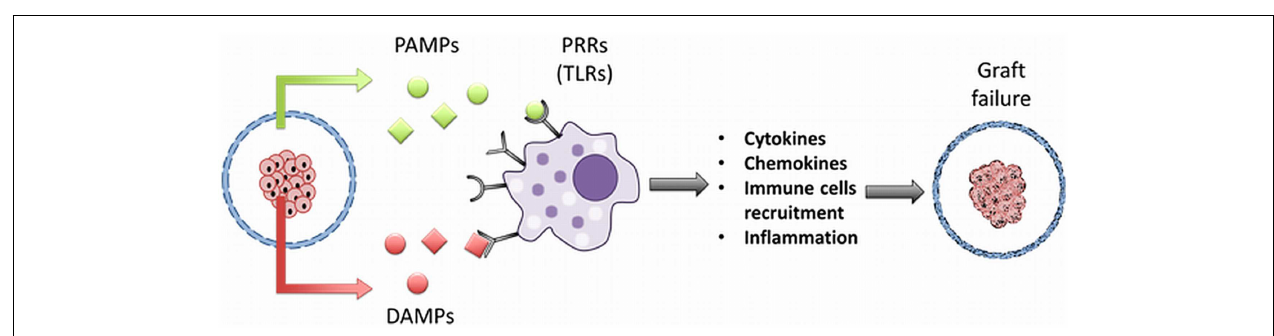
consequence. Encapsulated islets under stress, release molecules required for cellular homeostasis but in the extracellular space act like danger or damage-associated molecular patterns (DAMPs). DAMPs can also bind to PRRs activating both the innate and adaptive immune system in the